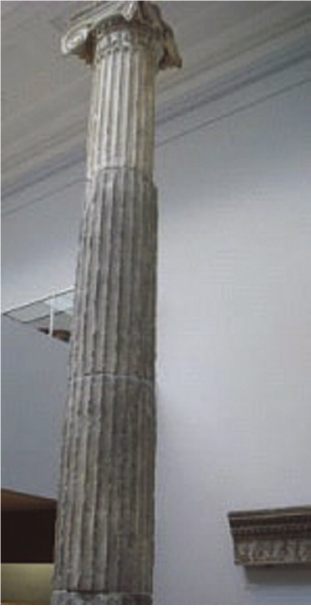
Figure 4: Erechtheion column.